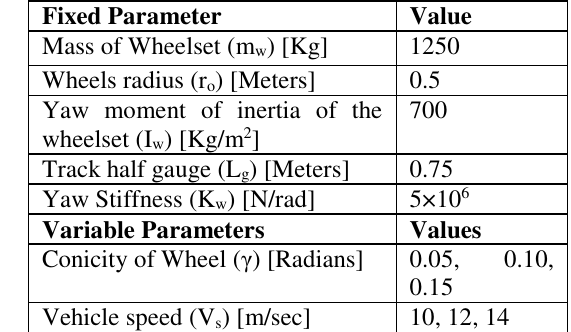
Table 1: Fixed and variable parameters used in simulation